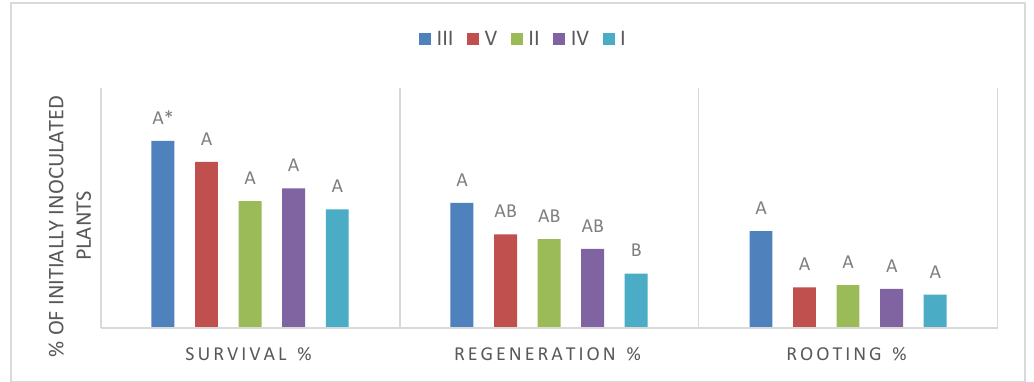
Figure 2. Effect of sanitary status on the survival, regeneration and rooting. Category of virus infection: I — GLRaV-3; II — GLRaV-1 + GLRaV-3; III — GLRaV-1 + GLRaV-3 + GFLV; IV — GFLV; V — GLRaV-3 + GFLV. * Different letters represent significantly different values according to Duncan ’ s test, p ≤ 0.05.